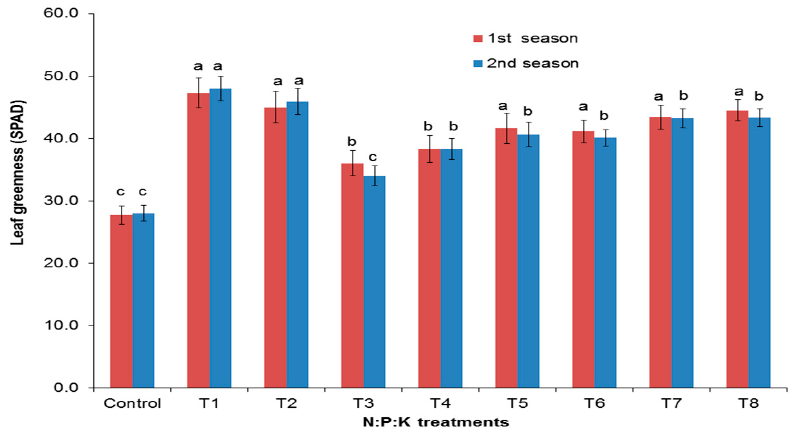
Figure 4. Effect of NPK doses on Salvadora persica leaf greenness. Dissimilar letters designate the significance among means ( p < 0.05) using Duncan’s multiple range test (means ± standard errors ( n = 5)) for the different fertilization treatments. Table 1. Effect of NPK doses on the vegetative parameters’ percentage of nitrogen, phosphorous, and potassium contents in Salvadora persica